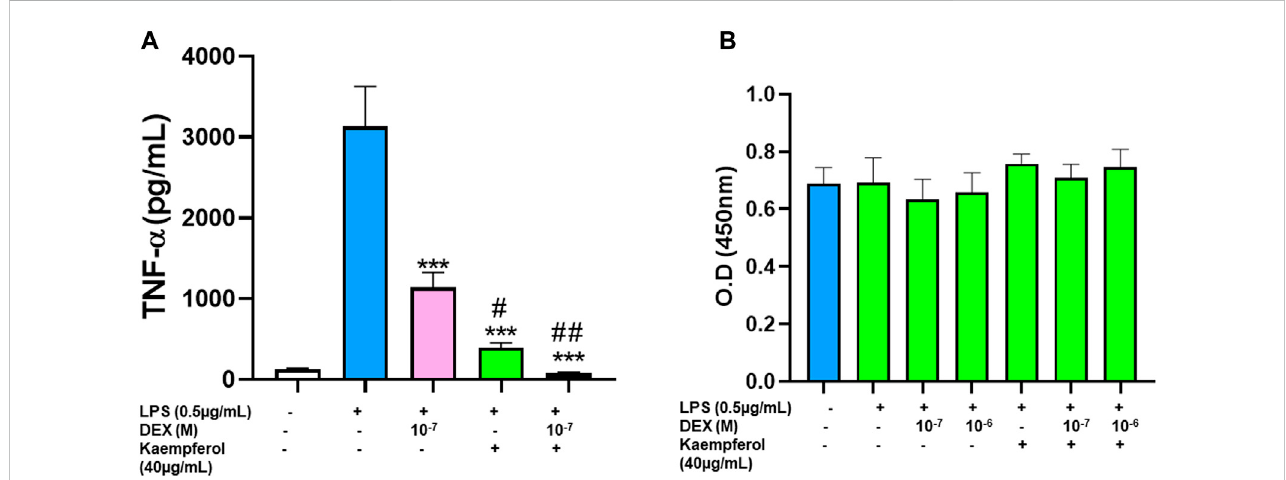
FIGURE 6 Effect of Kaempferol and dexamethasone co-culture on TNF- α production by RAW cells: Epimedium and dexamethasone synergistically suppressed TNF- α production RAW cells were cultured with Epimedium either alone or incombination with Dexamethasone for 24 h. The cells werestimulated with LPS (0.5 pg/m1). The supernatant were harvested and TNF- α levels were measured by ELISA. (A) Dexamethasone (10 – 7 ,10 – 6 M) and Kaempferol (40 pg/m1) signi fi cantly reduced TNF- α levels. When Kaempferol and dexamethasone was added together, the TNF- α levels were suppressed by 97%. (B) Cell viabilitywithCCK8assayshowednocellcytotoxicity.Datarepresentstriplicateexperimentsandexpressedasmean±SD." ’ p < 0.001 vs. control(withoutLPS), " p < 0.05; " p < 0.01 vs . Dex (10 − 7 M).